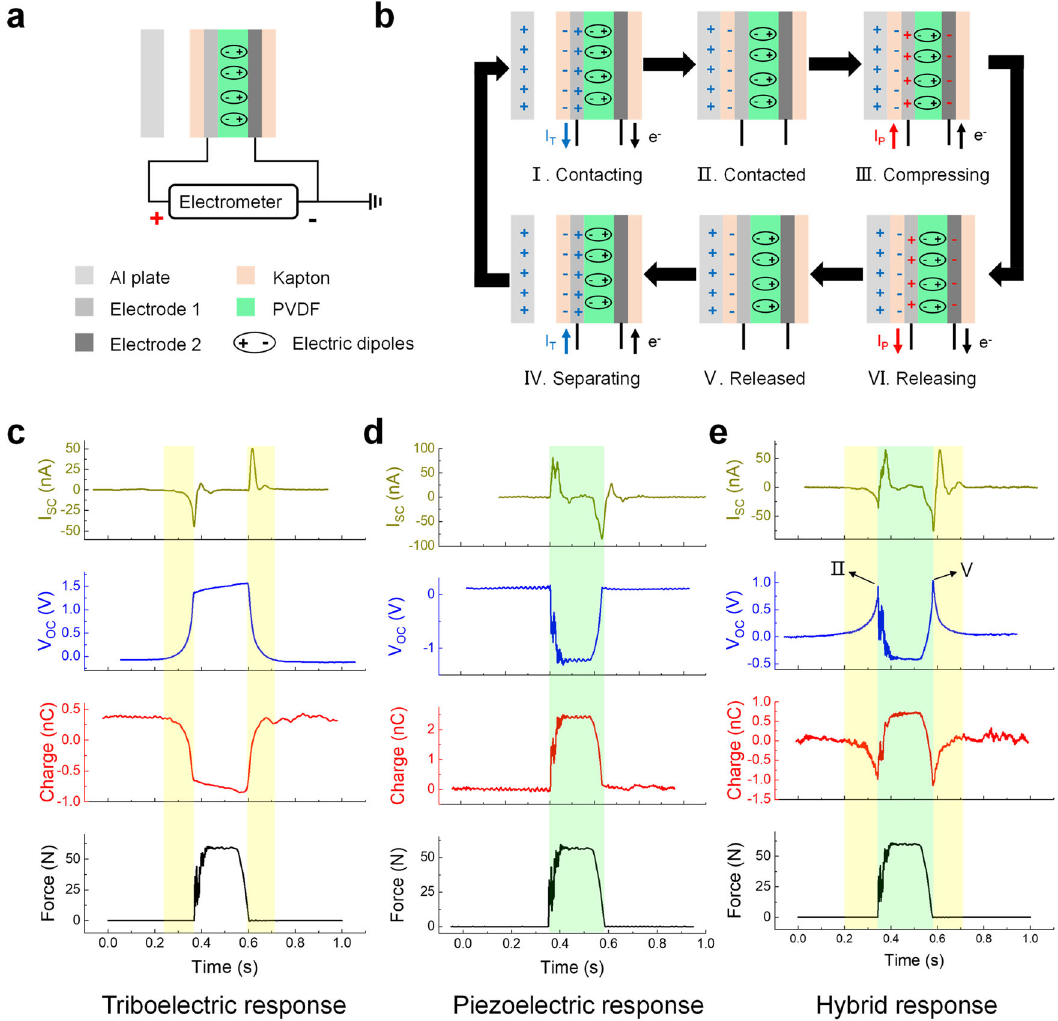
Fig. 4 The triboelectric-piezoelectric hybrid output generated by the PVDF-based device with the negative polarization direction. a Schematic of measuring the triboelectric-piezoelectric hybrid output in the negative polarization direction of the PVDF fi lm. b The signal generation process of hybrid output contains six stages including contacting, contacted, compressing, releasing, released, and separating stages. c The sole triboelectric signals ( I SC , V OC , and charge) are generated by the PI-based device at 60 N. Sole triboelectric signals are generated in the stages of contacting and separating (light yellow area). d The sole piezoelectric signals ( I SC , V OC , and charge) are generated by the PVDF-based device with shielding layer at 60 N. Sole piezoelectric signals are generated in the stages of compressing and releasing (light green area). e The triboelectric-piezoelectric hybrid signals ( I SC , V OC , and charge) are generated by the PVDF-based device at 60 N. The hybrid signals exist in the stages of contacting, compressing, releasing, and